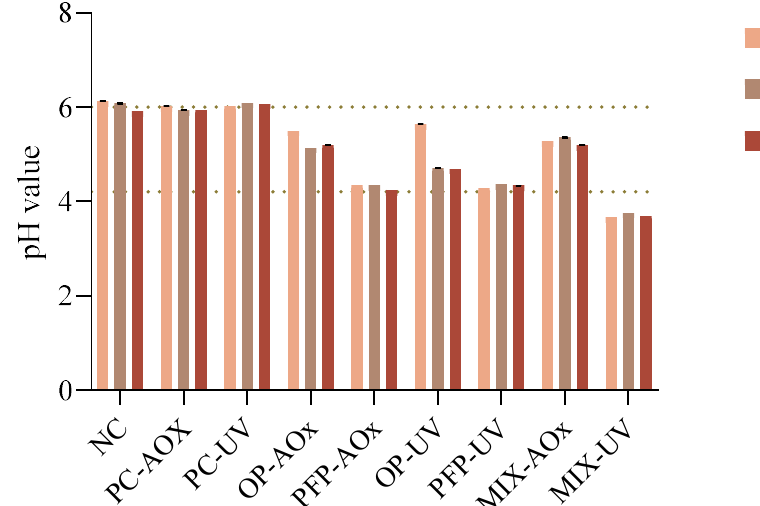
Figure 5. Variation in the pH value of the different formulations for the three study times: t 0 —week of production; t 1 —two weeks after production; t 2 —four weeks after production. NC: negative control; PC-AOx: positive antioxidant control; OP-AOx: onion peel extract antioxidant sample; PFP-AOx: passion fruit peel extract antioxidant sample; Mix-AOx: mixture of antioxidant control and OP and PFP extract; PC-UV: positive UV filter control; OP-UV: onion peel extract UV filter sample; PFP-UV: passion fruit peel extract UV filter sample; Mix-UV: mixture of UV filter control and OP and PFP extract.